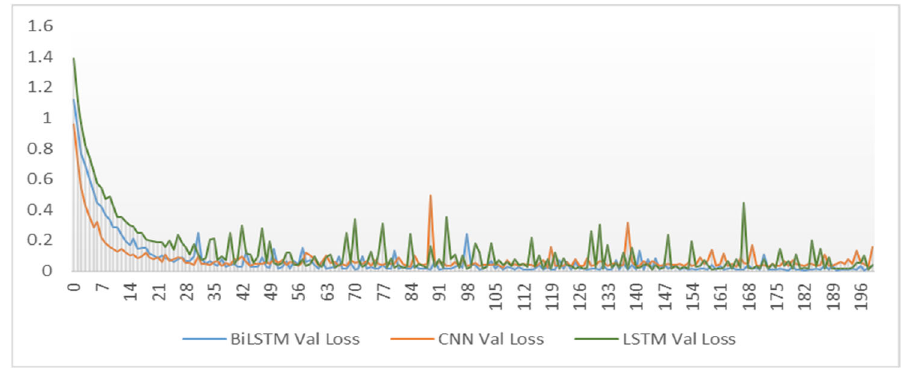
Figure 8. Loss of the validation datasets.